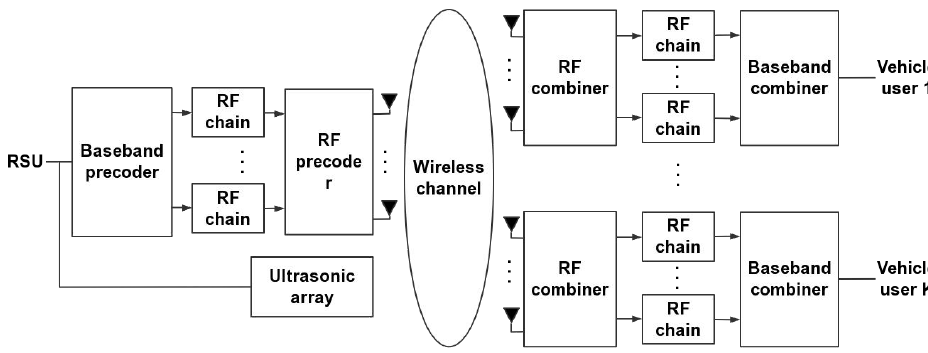
Figure 1. Channel hybrid precoding structure for ultrasonic-aided multi-user millimeter-wave massive MIMO system. On the left is the RSU with the wireless communication module and the ultrasonic module, and on the right are the